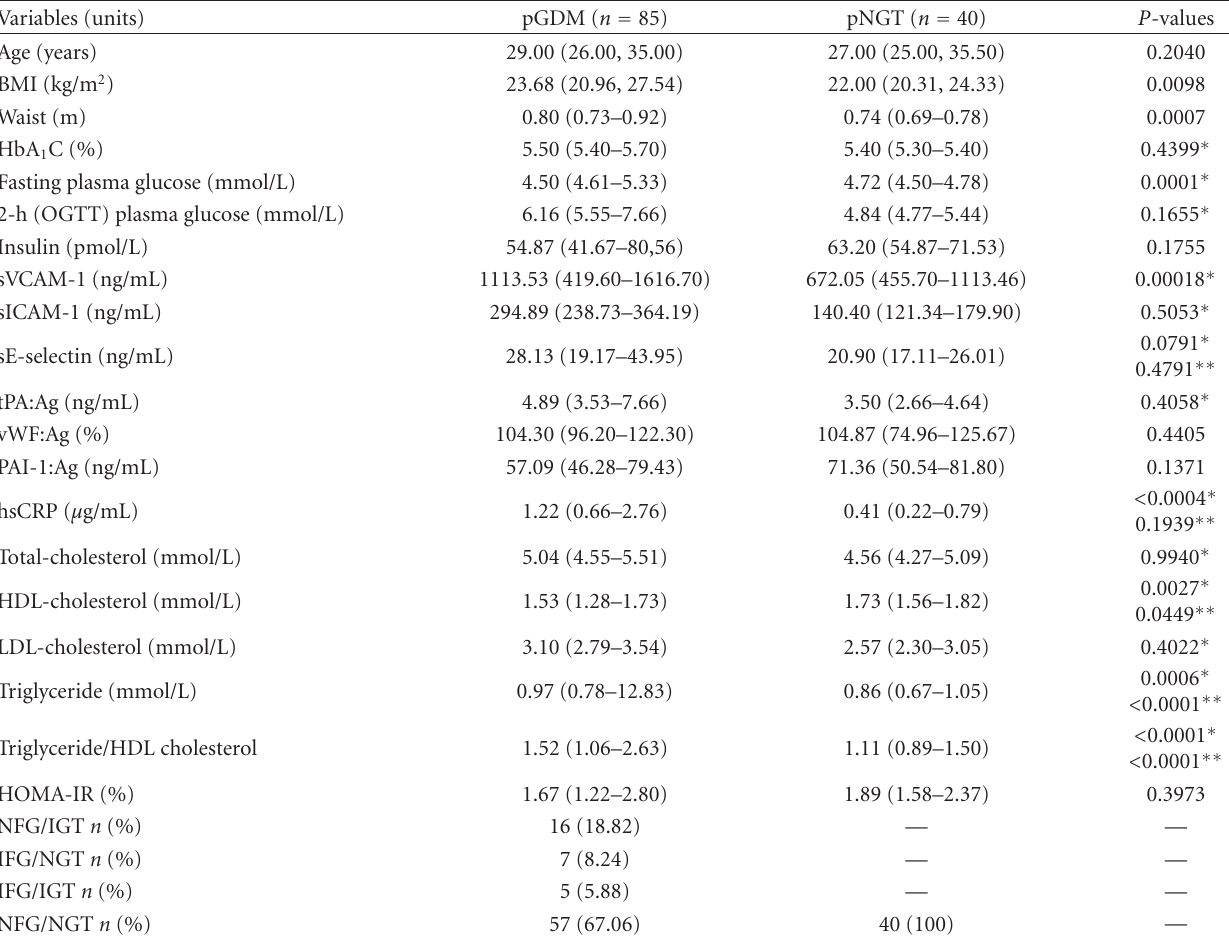
Table 1: Characteristics of women with previous history of GDM (pGDM group) and control participants with normal glucose regulation during pregnancy (pNGT